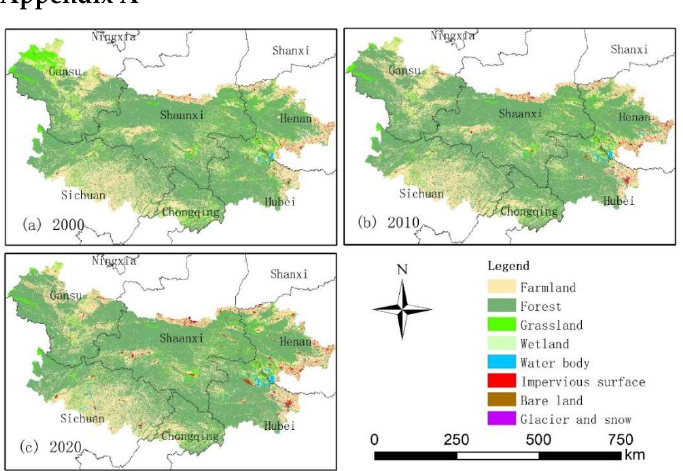
Figure A1. Land-use patterns in the Qinling-Daba Mountains in 2000, 2010, and 2020.